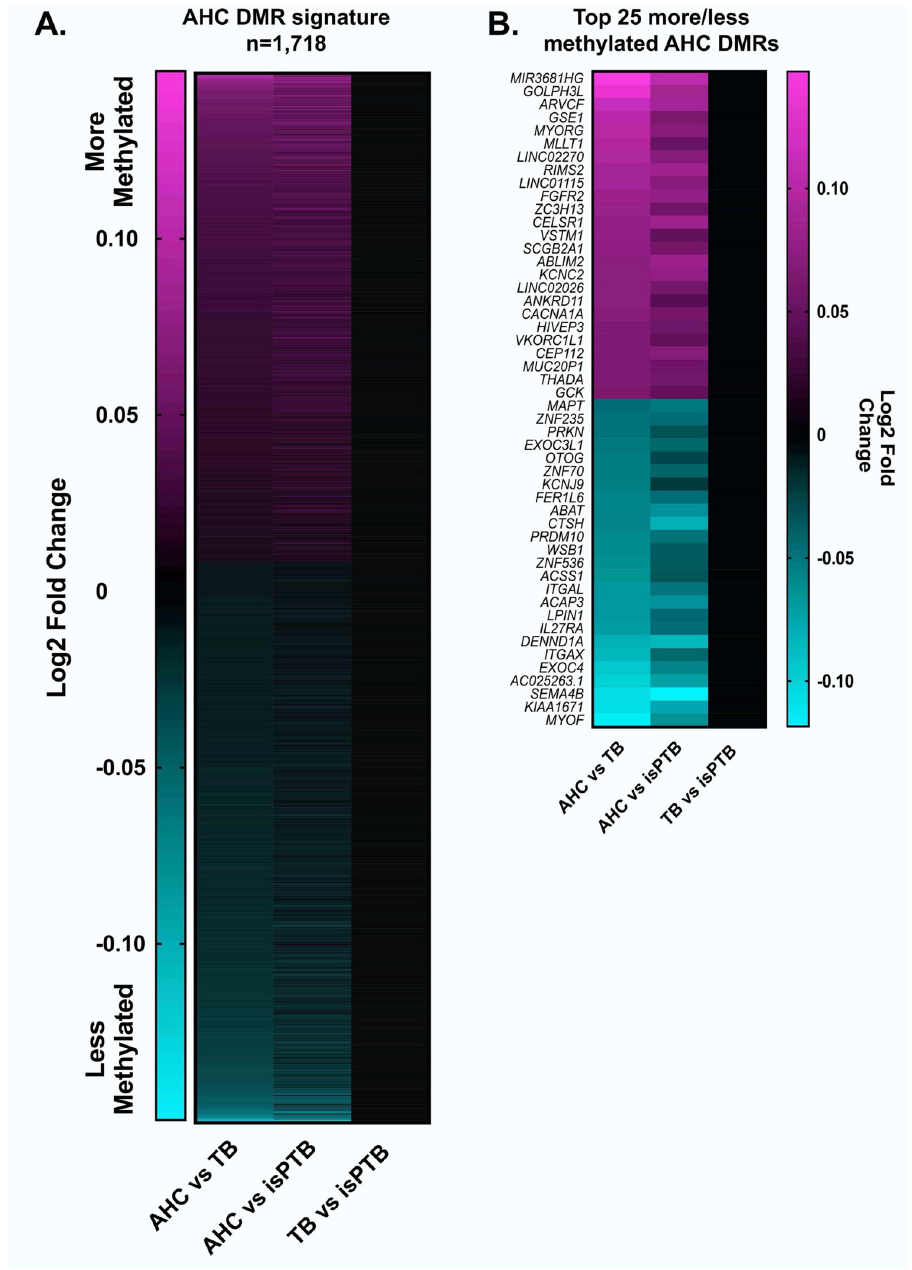
Fig 4. AHC specific DMR profile. A. Differentially methylated DMRs were identified by differences in the mean of the probe values across the DMR. AHC specific DMRs are defined by when the AHC DMRs were differentially methylated compared to the TB or isPTB DMRs. B. The top 25 more and less methylated DMRs demonstrates the clarity of the molecular profile, as there is no significant differential methylation in the TB vs isPTB comparison. changes in placenta and upregulated senescence markers as well as mitotic inhibition [86]. CDKN2B-AS is a functional RNA with regulatory roles via interaction with PRC1 and PRC1 which regulates the rest of the genes in this locus epigenetically [87]. Additionally, CDKN2B-AS , also known as ARNIL , has been implicated in preterm birth.